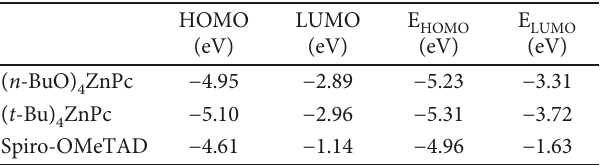
Figure 2: 5 μ m × 5 μ m AFM image of a ( n -BuO) nonconductive glass. The color scale ranges from 0 nm (black) to 143nm (white). Table 2: HOMO (LUMO) values of isolated molecules calculated at the B3LYP level of theory and E HOMO E LUMO voltammetric potentials of the same molecules in CH 2X level of theory in the case of (n-BuO) Spiro-OMeTAD. Oxidation and reduction potentials have been calculated as Δ G values between neutral and charged species, as detailed in [21].